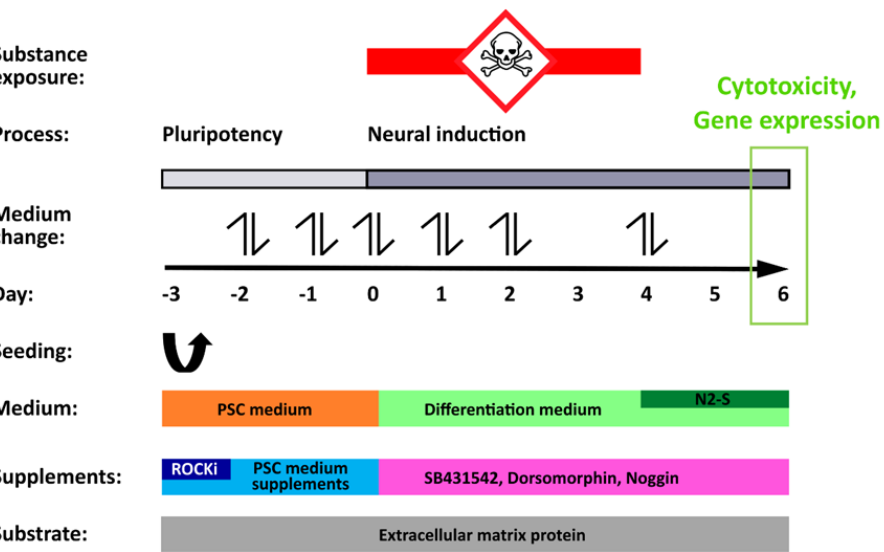
Figure 1. Schematic representation of the UKN1-test (modified from [20,37]). The overview scheme depicts the differentiation protocol, important experimental steps, and the principal of the toxicity assay. In the pluripotency phase (day − 3 to 0), hiPSCs were cultured in a pluripotent stem cell (PSC) medium to maintain their pluripotent state. Factors that inhibited Rho-kinase (ROCKi) were additionally given on the day of seeding (day − 3) to support the survival of hiPSCs seeded as single cells on extracellular matrix proteins. From day 0 onwards, the change to a differentiation medium spiked with SB431542, dorsomorphin, and noggin initiated neuroectodermal differentiation of the cells. Simultaneously, cells were exposed to test compounds for a total of 96 h. On day 4, substances were withdrawn and addition of 25% N2-S further enhanced the neural differentiation process. On day 6, compound-induced cytotoxicity was determined and the cells were harvested for gene array analysis. Media changes were conducted as indicated (double arrows) on the days − 2, − 1, 0, 1, 2, and 4.